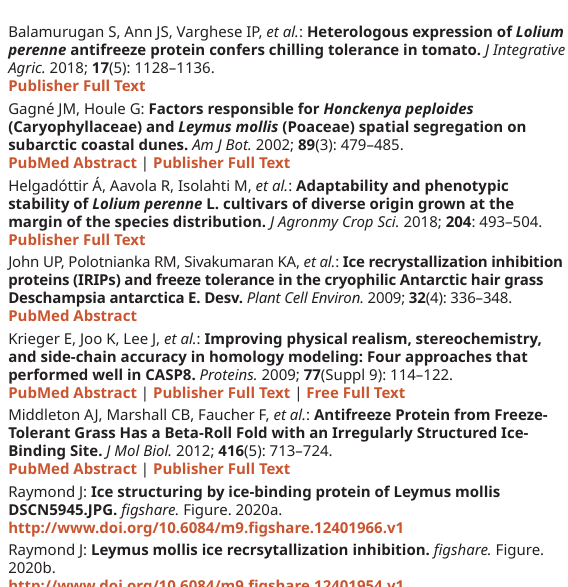
Figshare: Leymus mollis ice recrsytallization inhibition. https:// Figshare: PCR amplification of IBP and 18S genes of